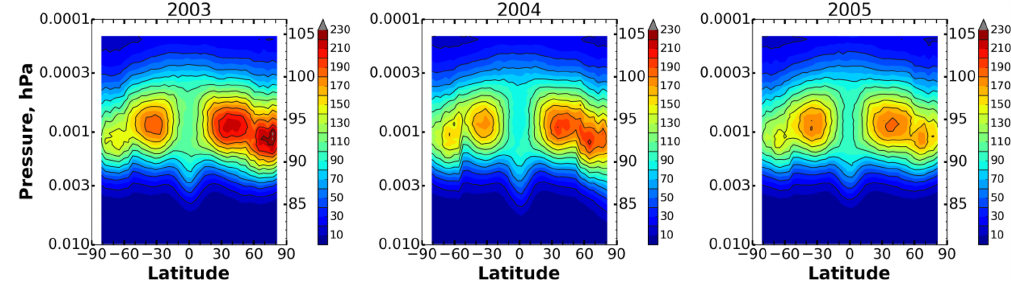
Figure 4. Annually averaged O( 1 D) concentration (in cm − 3 ) in